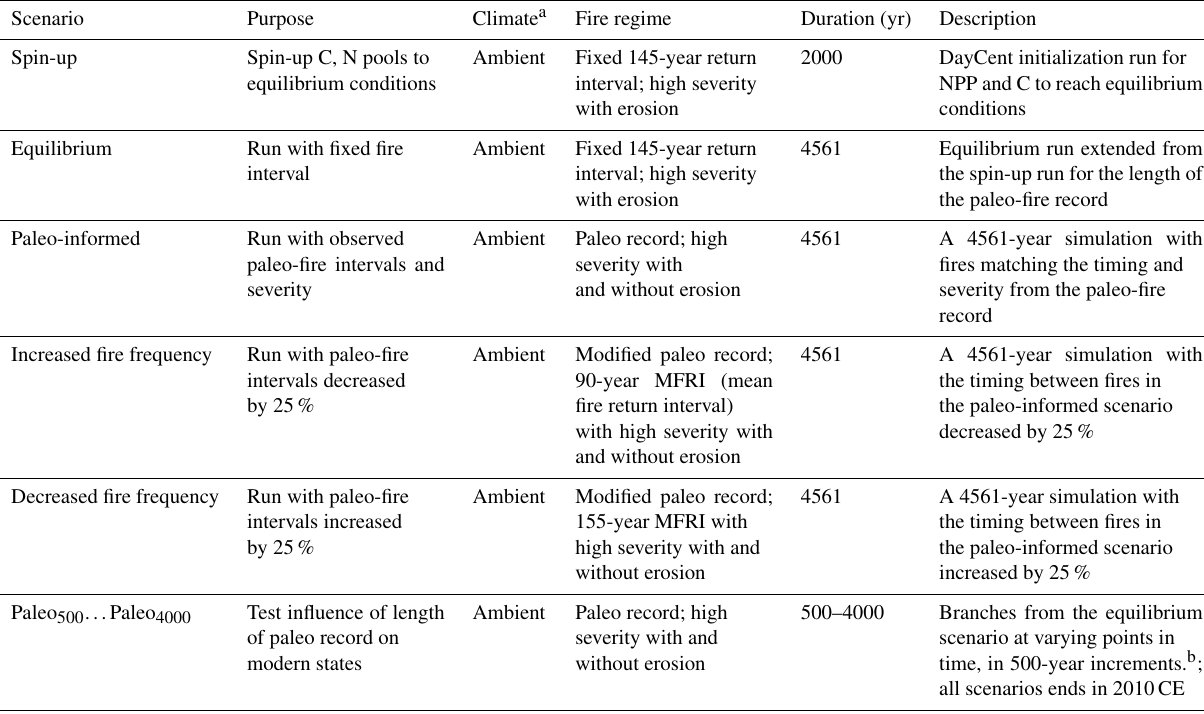
Table 1. Model simulation scenarios, including climate, fire regime, duration, and summary